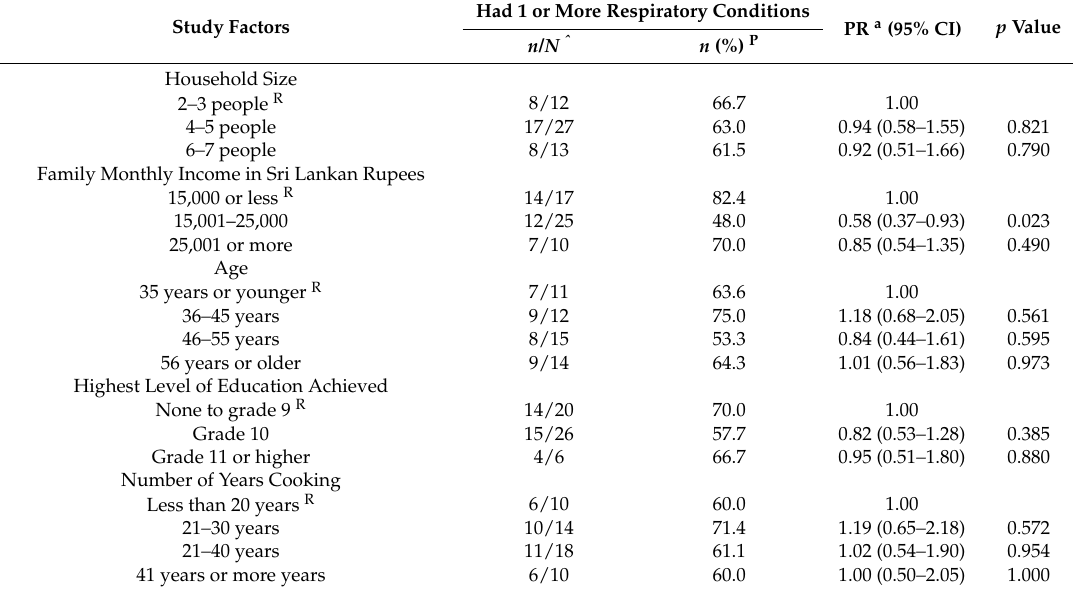
Table 3. Prevalence ratios for respiratory conditions among cooks by demographic and household exposure